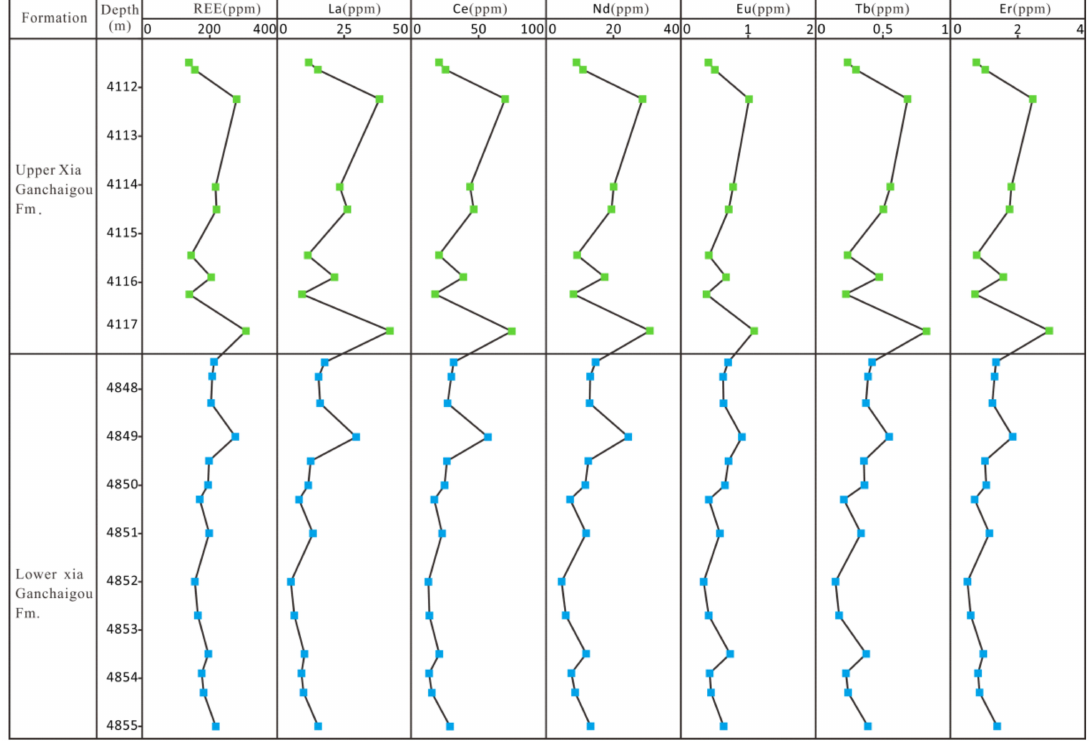
Figure 8. Rare earth elements contents in the Xiaganchaigou Formation of the Lenghuqi